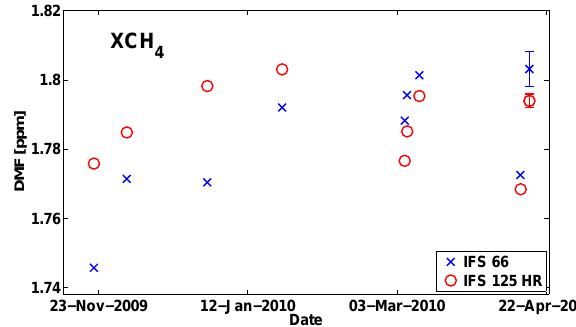
Fig. 7. Daily averages of XCH 4 , as measured by the IFS66 and the IFS125HR. The statistics are calculated as described for XCO 2 in Fig.